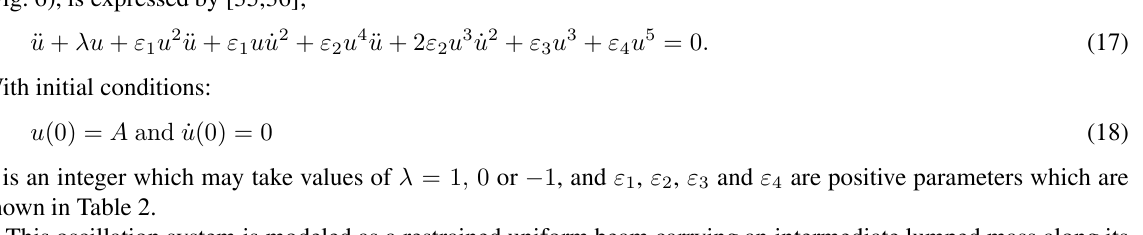
Fig. 2. The comparison between frequency-amplitude formulation with Runge-Kutta 4 th order for fi rst mode, when A = 1. Where ω is evaluated from Eq.